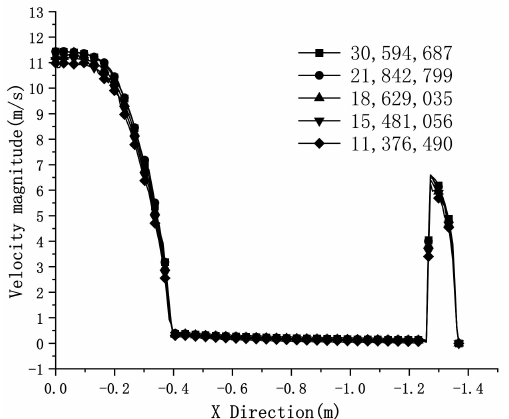
Figure 7. Velocity variation along the radius in the reactor at Y = 4 with 5 different mesh sizes.